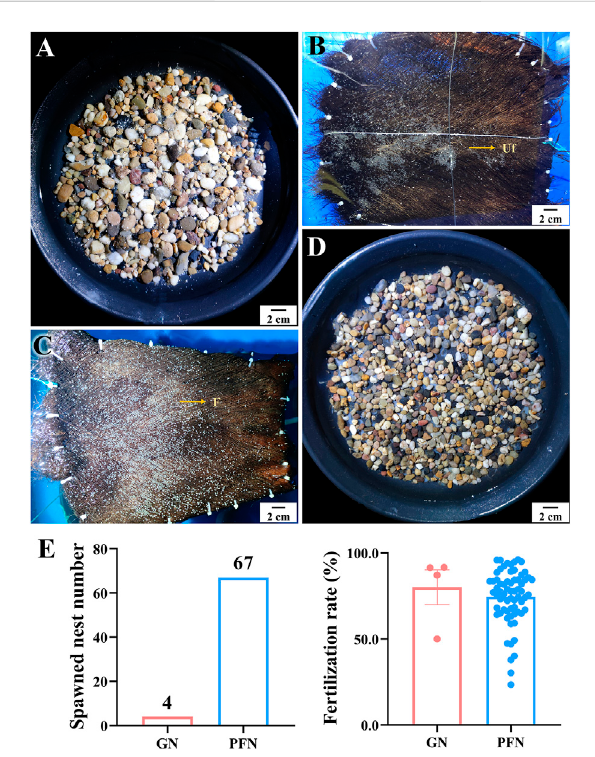
FIGURE 11 Spawning nest preference and fertilization rates on palm fi ber nest and gravel nest of largemouth bass. (A, B) Spawned eggs on gravel nest (GN) and palm fi ber nest (PFN) in out-of-season spawning, respectively. (C, D) Spawned eggs on PFN and GN in in-season spawning,respectively. (E) Comparison ofspawnednest numbers and fertilization rate between GN and PFN.